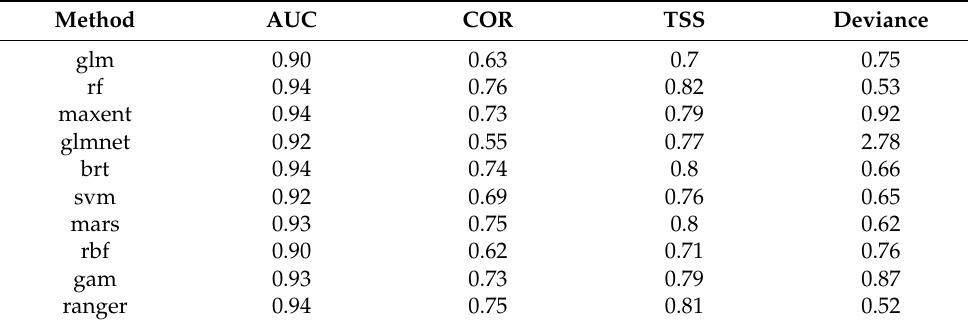
Table 1. Accuracy evaluation statistics of models used for ensemble